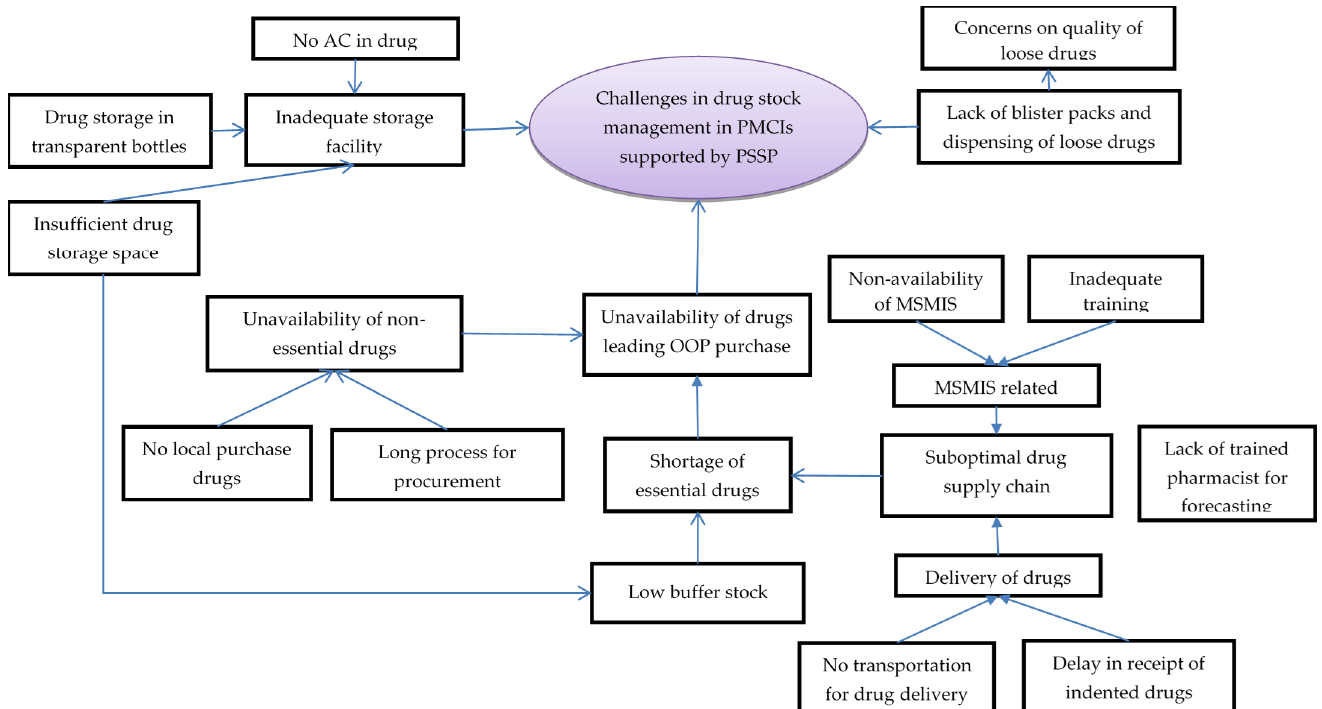
Figure 3. Challenges in drug stock management in PMCIs supported by PSSP in Sri Lanka, 2021. Ab- breviation: PMCI: Primary Medical Care Institution; PSSP: Primary